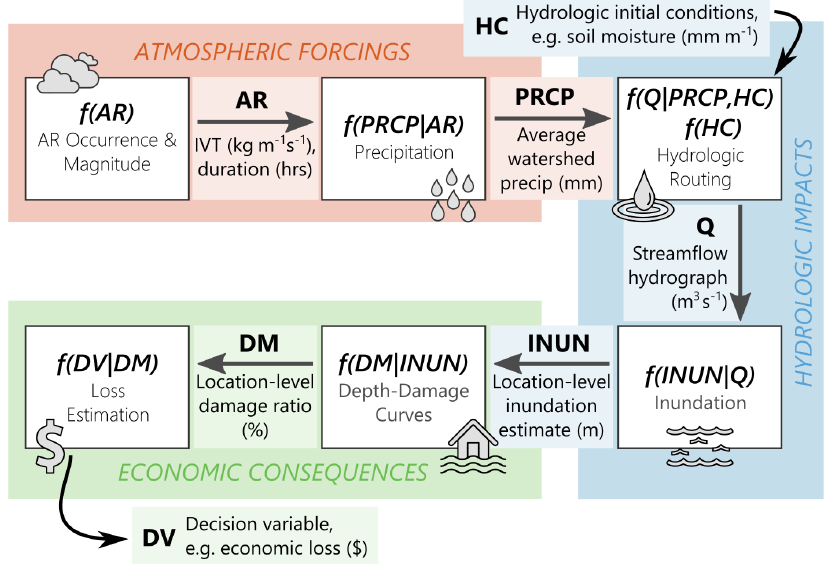
Figure 1. PARRA framework flowchart. Graphical depiction of the PARRA framework, as presented mathematically in Eq. (2). White boxes represent component models. Arrows represent pinch points: an arrow pointing toward a box indicates a required component model input, and an arrow coming out of a box indicates a component model output. The background colors broadly represent existing research